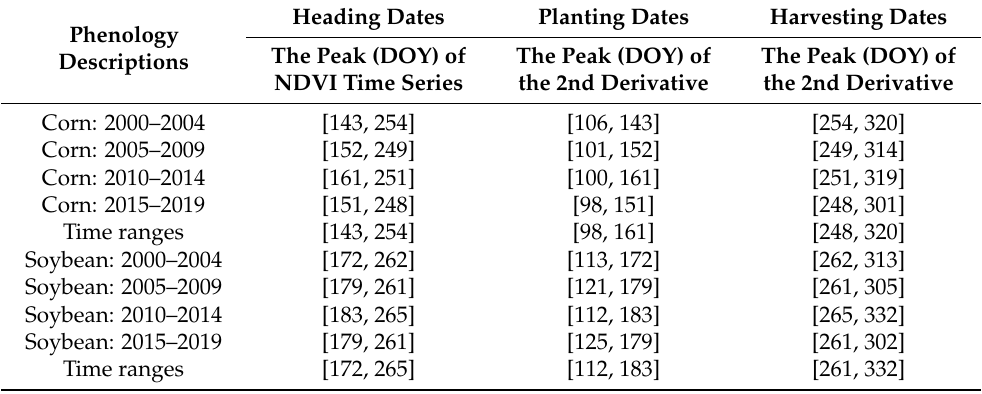
Table 2. Parameter thresholds derived from the crop reports dataset used for crop phenology